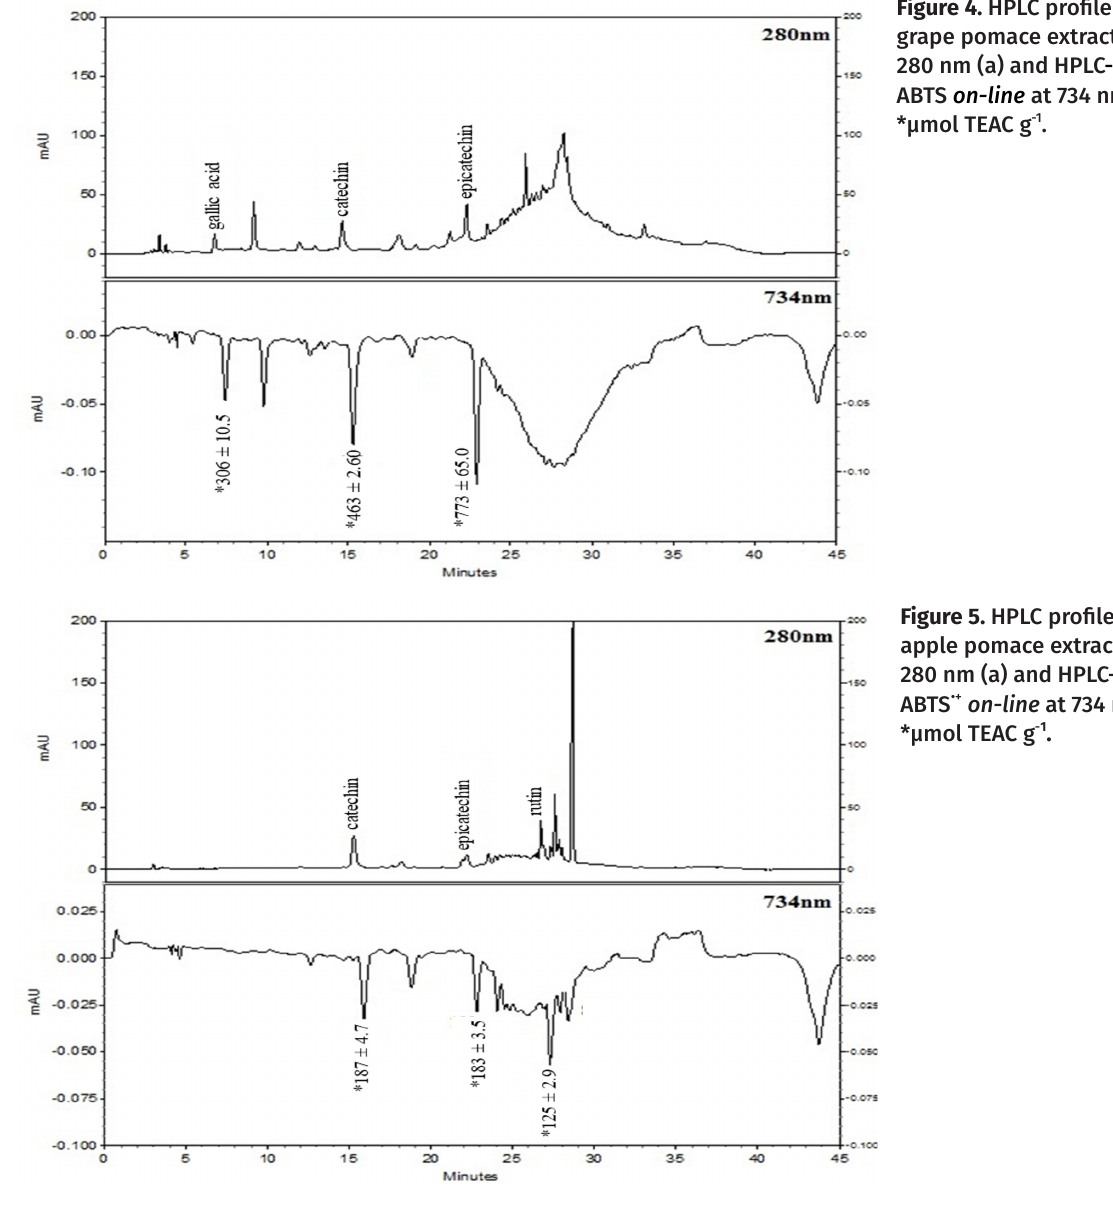
Figure 5. HPLC profile of apple pomace extract at 280 nm (a) and HPLC-FR- ABTS •+ on-line at 734 nm (b). *µmol TEAC g - 1